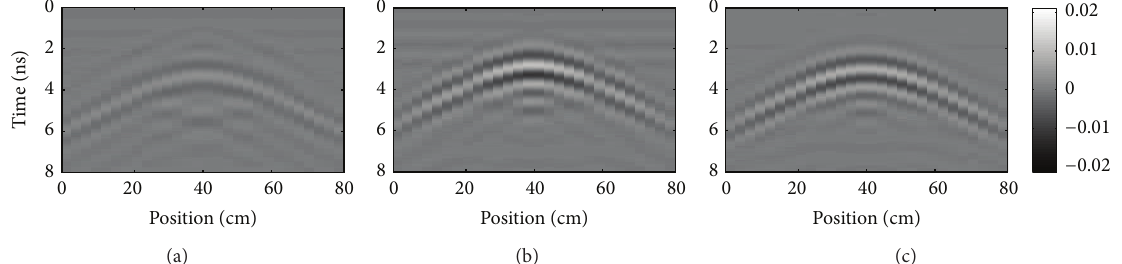
Figure 5: GPR B-scan synthetic radargrams for a vacuum sphere of 5cm radius, buried 10cm deep from an air/sand interface. Grey-scale received-signal amplitude in time versus longitudinal scanning position along 𝑥 , for three parallel lines at different 𝑦 : (a) line 1; (b) line 5; (c) line